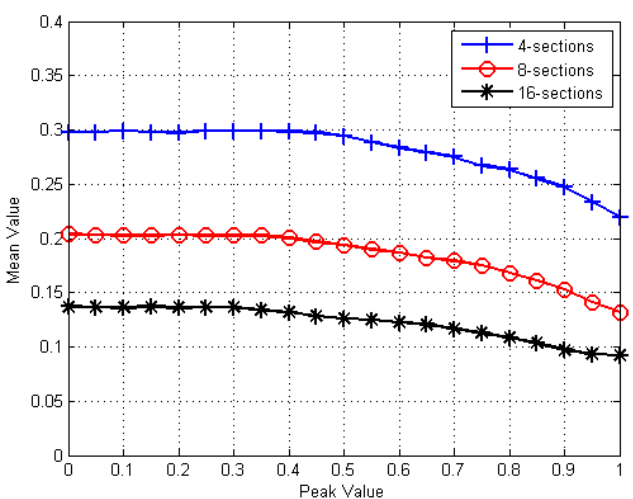
Figure 14. Relationship between peak value and mean value within main lobe width.